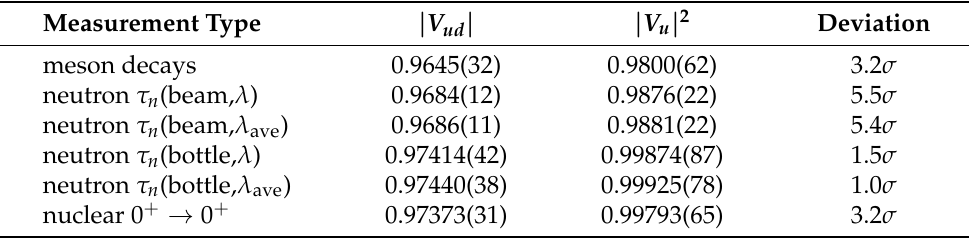
Figure 5. V ud values from different types of decay measurements and their deviations from unitarity of the CKM matrix for the first row of | V u | 2 = | V ud | 2 + | V us | 2 + | V ub | 2 are plotted. Table 3. V ud values from different types of decay measurements are listed and their deviations in σ -level from unitarity of the CKM matrix for the first row of | V u | 2 = | V ud | 2 + | V us | 2 + | V ub | 2 are shown based on | V us | = 0.22308 ( 55 ) from Equation (5) and | V ub | = 0.00382 ( 20 )